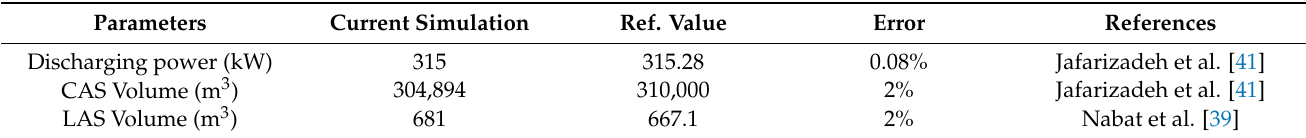
Table 3. Validation of current simulation with former evaluations.